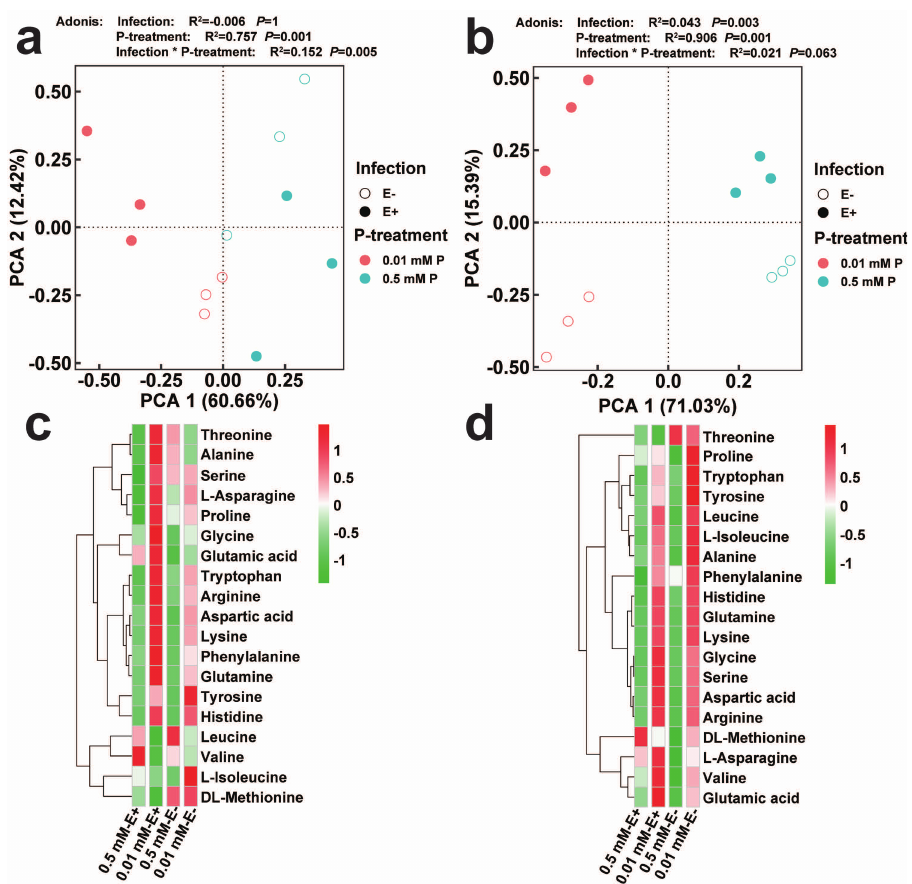
Figure 10. Principal component analysis for Epichloë gansuensis -infection and the different P concen- tration treatment with the content of amino acids in leaves ( a ) and roots ( c ). The content of amino acids with heatmap in leaves ( b ) and roots ( d